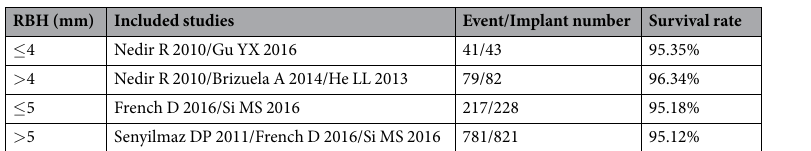
Table 3. Survival rates of implants for different RBHs using a graft-free